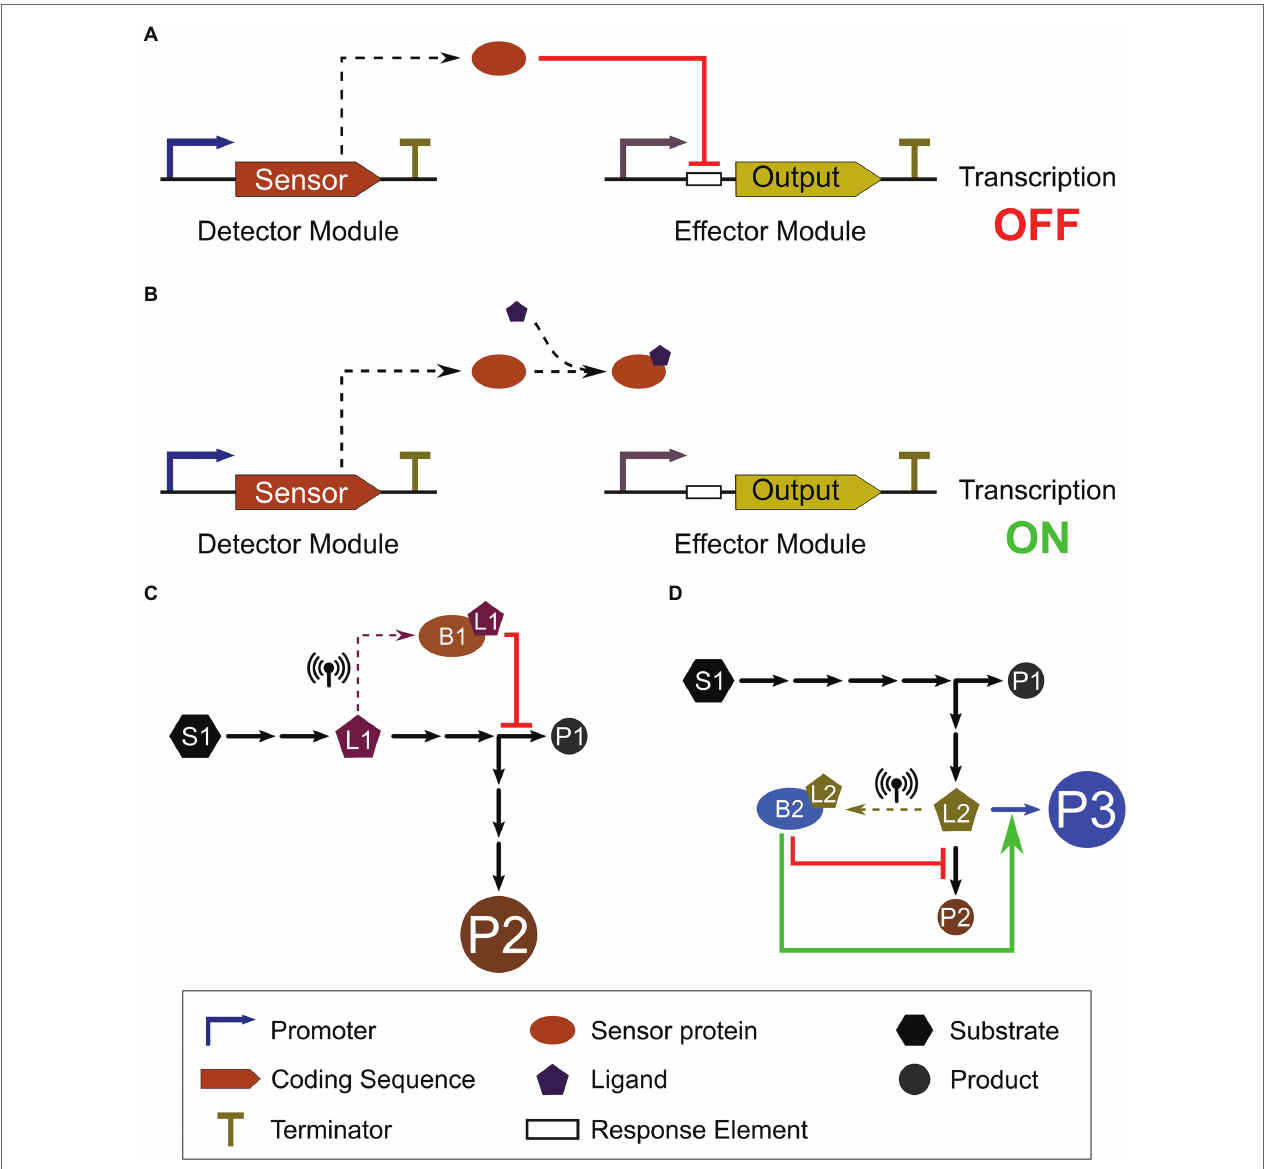
FIGURE 2 | Metabolite-induced transcriptional de-repression in a biosensor system and genetic circuit application to control metabolism. (A) In the absence of the ligand (metabolite), the constitutively expressed repressor sensor protein binds to its response element on the target promoter (effector module), repressing expression of the output. (B) Conformational changes in the repressor sensor protein caused by its binding to the ligand precludes its association to the response element on the target promoter; therefore, repression is relieved and transcription of the output can occur. (C) A putative metabolic pathway converts substrate S1 into product P1, with a branching point to produce an alternative product P2. As the intermediate metabolite (ligand) L1 reaches a threshold concentration, it is sensed by biosensor B1 (dashed arrow), triggering repression of P1 production, thus diverting carbon flux toward P2 production and increasing P2 yield (represented by larger circle). (D) The same pathway can be engineered into multipart operations, for example, to produce a new product, P3, by a transgene enzyme (blue arrow). Biosensor B2 can sense the flux into P2 by the intermediate metabolite L2 (dashed arrow). As L2 reaches a threshold concentration, B2 represses production of P2, while activating the transgene expression (blue arrow), yielding the new product P3. These biosensors can act directly or indirectly, depending on their mode of action (repressor or activator) and the complexity of the genetic circuit. Different inputs can be combined and layered to build more complex operations and genetic circuits. As L1 and L2 concentrations return to levels below the biosensor threshold, the circuits are deactivated, restoring pathway